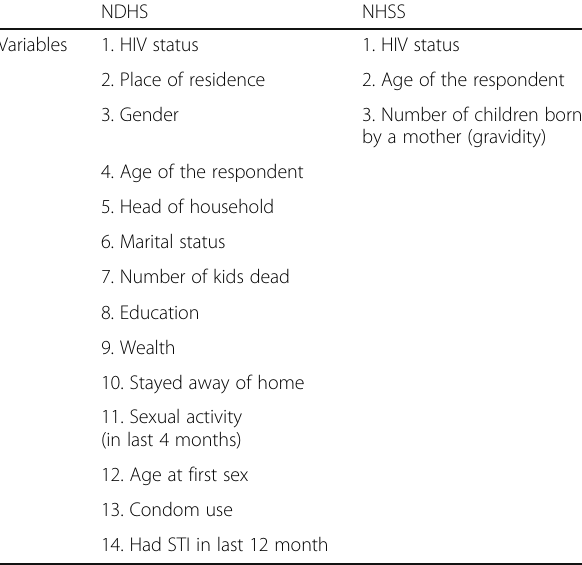
Table 1 Summary of variables used in the study by